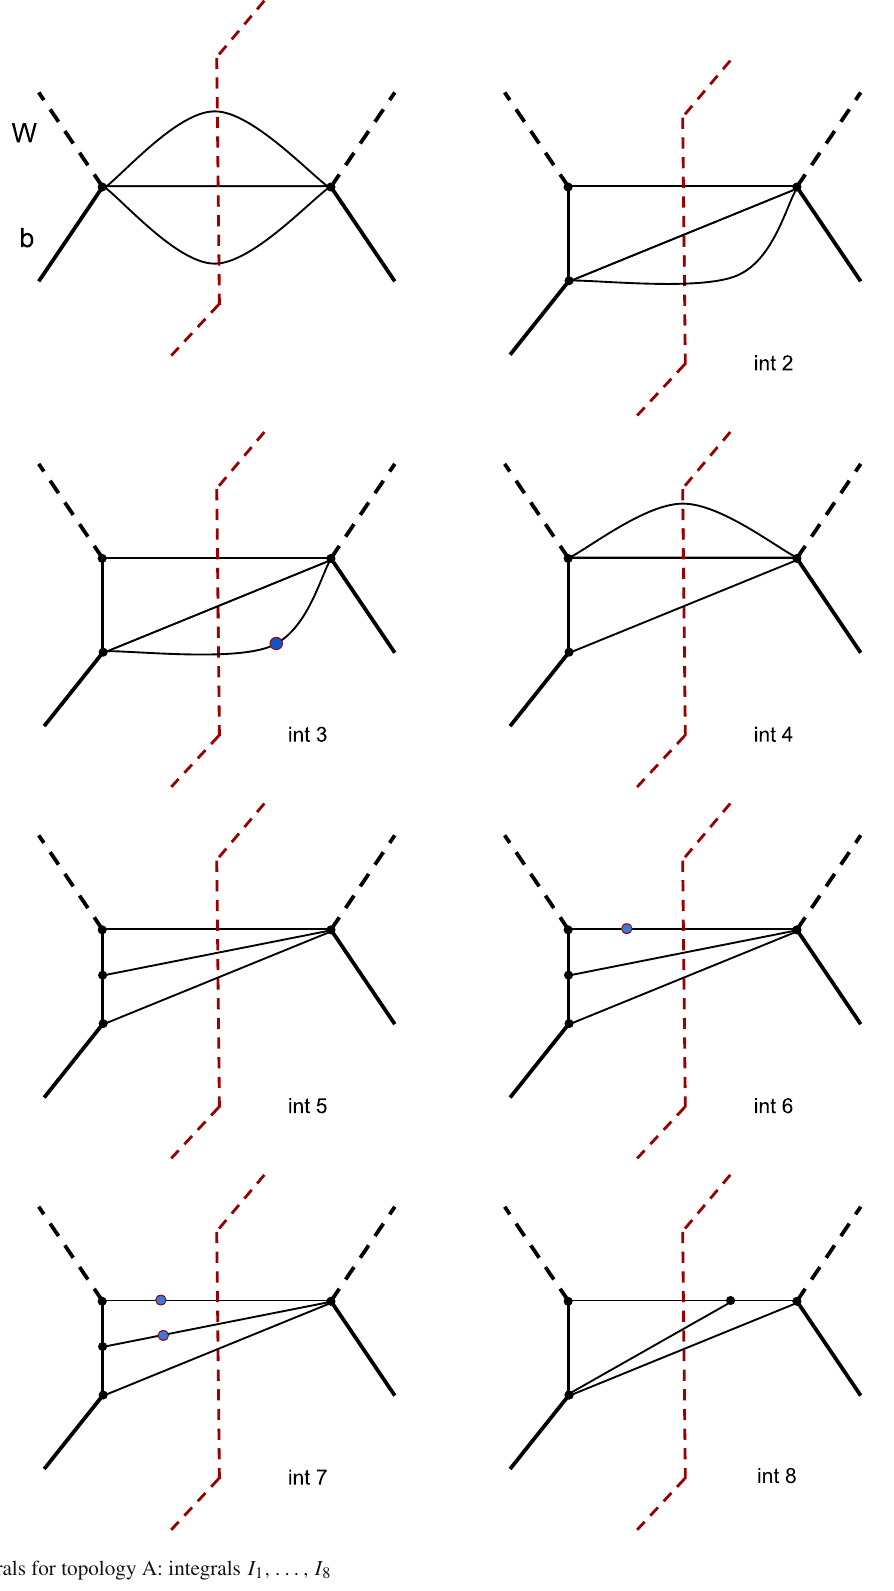
Fig. 2 Master integrals for topology A: integrals I 1 ,..., I